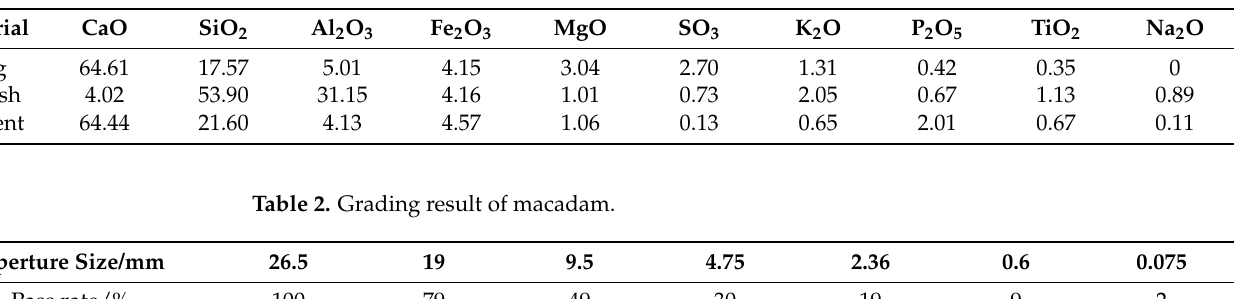
Table 1. Chemical composition of raw materials (wt.%).